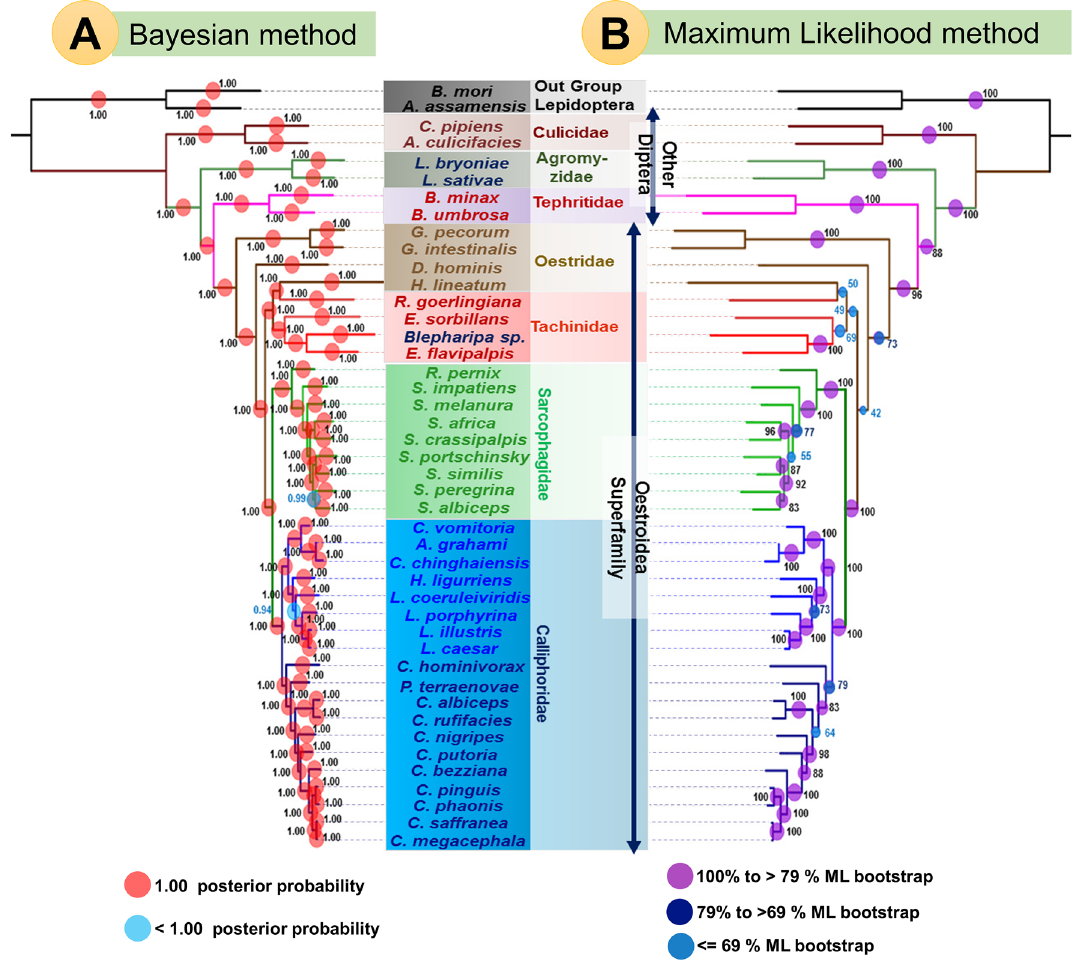
Figure 8. ( A ) Phylogenetic tree inferred from nucleotide sequences of 13 PCGs of 44 organisms (36: Oestridea superfamily, 6: other Diptera and 2: Out group Lepidoptera) using maximum likelihood (ML) method in RaxML 8.2.x (5000 bootstrap replicates). ( B ) Phylogenetic tree inferred from nucleotide sequences of 13 PCGs of 44 organisms (36: Oestridea superfamily, 6: other Diptera and 2: Out group Lepidoptera using Bayesian inference (BI) method in MrBayes